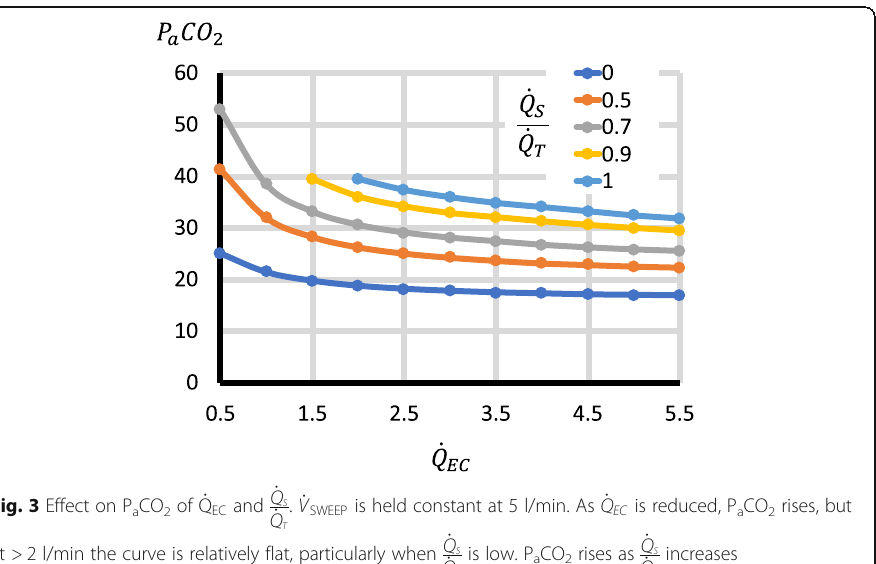
_ Q S _ is low. P a CO 2 rises as Q T